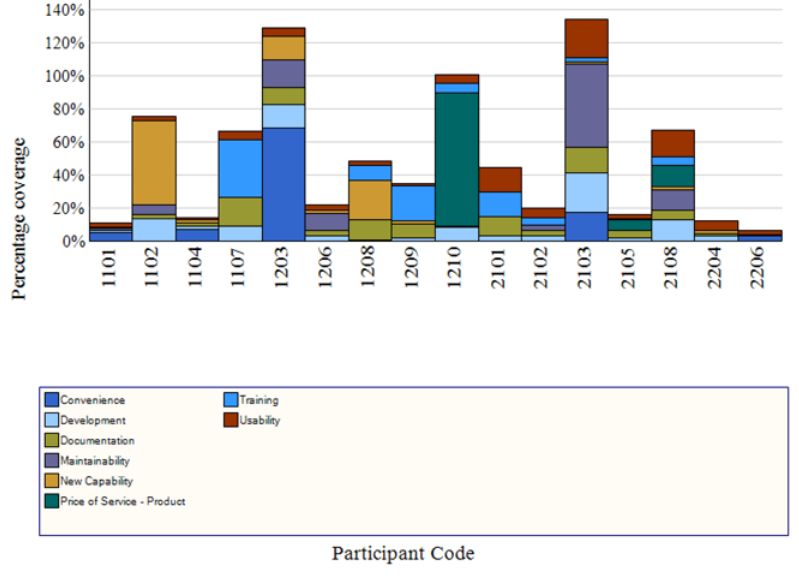
Figure 5 Variations of Responses by